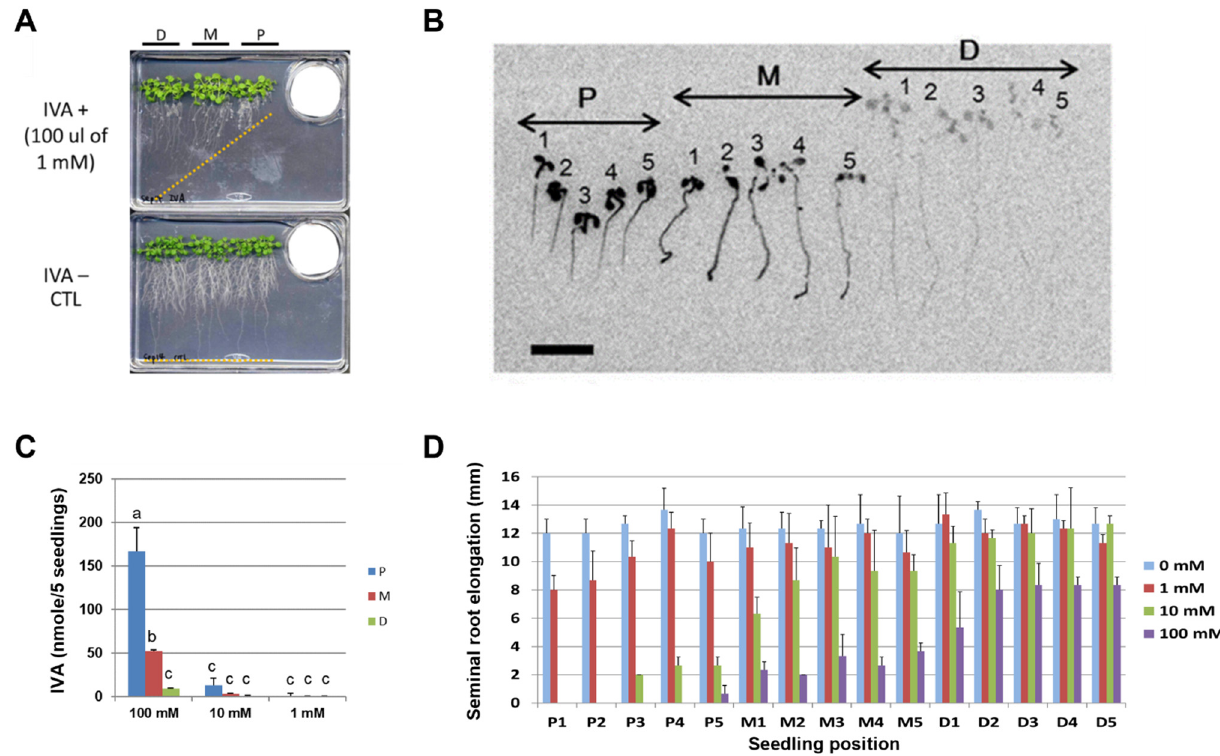
Figure 2. IVA exhibits growth-inhibitory activity towards Arabidopsis seedlings. P: proximal; M: mid; D: distal. ( A ) The elongation of the Arabidopsis seminal root was inhibited by the vapor of the IVA standard. The standard solution of IVA was spotted onto filter paper placed in a 35 mm dish, and the Arabidopsis seedlings were subjected to the bioassay. Orange dotted line: positions of root tips on Day 14 of the bioassay. ( B ) Autoradiogram of the Arabidopsis seedlings pre-cultured without IVA for 5 days and exposed to the vapor of 100 µL of 10 mM IVA (a mixture of non-radiolabeled and 14 C-labeled IVA) that was spotted onto filter paper in a 35 mm dish. The Arabidopsis seedlings were imaged after 3 days of co-culturing. The numbers represent the position of each seedling relative to 35 mm dish. Bar = 1 cm. ( C ) The amount of 14 C-labeled IVA absorbed per five seedlings was quantified by a phosphor imager, 1–100 mM; The concentrations of 14 C-labeled IVA solutions used in the assay. Different letters indicate significant differences according to Tukey’s means comparison test ( p ≤ 0.05). Error bars represent the SD. (n = 3) ( D ) Seminal root elongation of the Arabidopsis seedlings after exposure to 14 C-labeled IVA. P1–P5, M1–M5, and D1–D5 correspond to the position of each seedling relative to the source of 14 C-labeled IVA. Different concentrations of IVA (0, 1, 10, and 100 mM) were used in the experiment. The error bars represent the SD. (n = 3). P: proximal position; M: mid position; D: distal position.